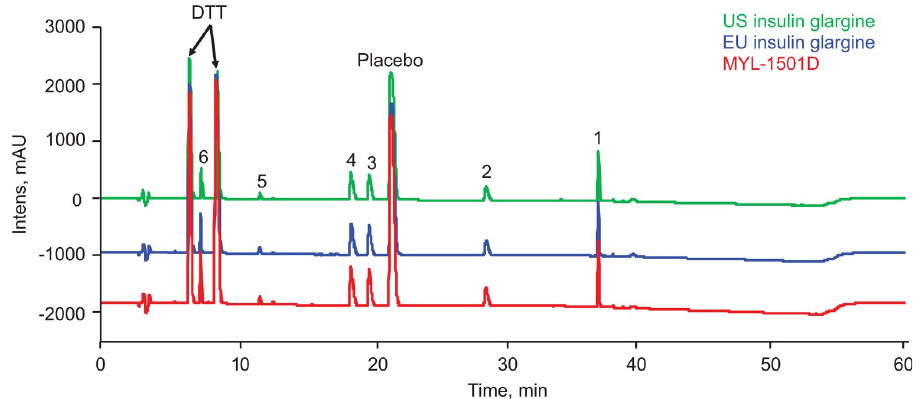
Fig 1. Structural characterization and comparison of MYL-1501D, US- and EU-licensed insulin glargine. Representative overlay of chromatographic peak profile of reduced peptide mass fingerprinting from MYL-1501D and reference products. Fragments 1–6 are described in Table 1. DTT,